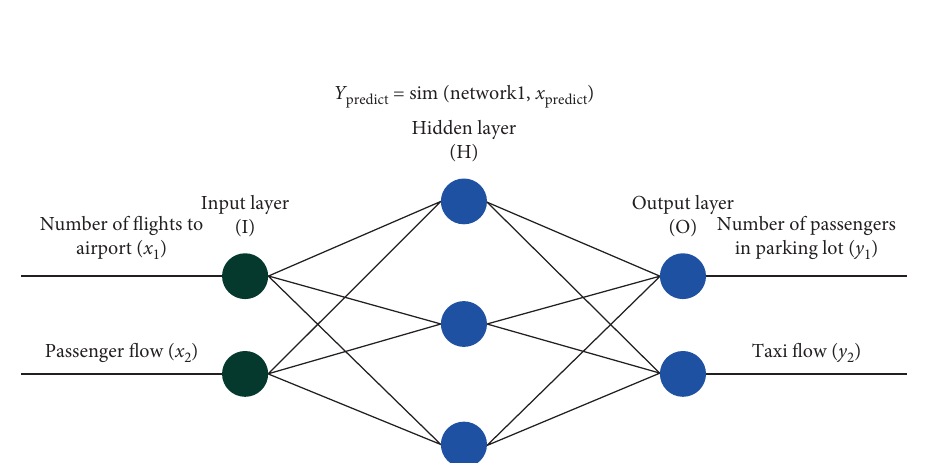
Figure 2: BP network flow